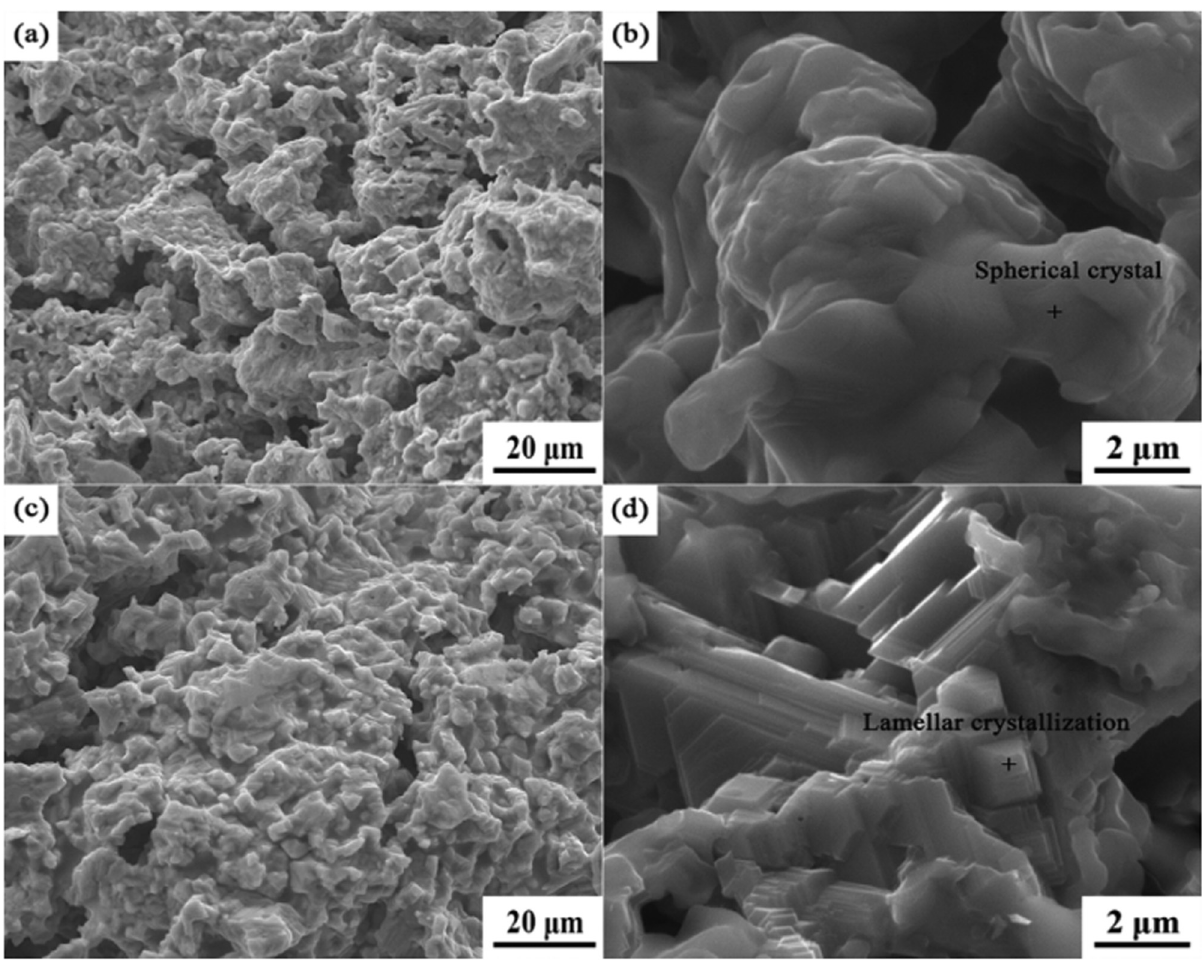
Figure 11: SEM images of reduced briquettes at the second stage. ( a and b ) 0 wt% ( K 2 O + Na 2 O ) , ( a and c ) on macrography, ( c and d ) : 0.6wt% ( K + Na ) , ( b and d ) on microcosmic. 2 O 2 O